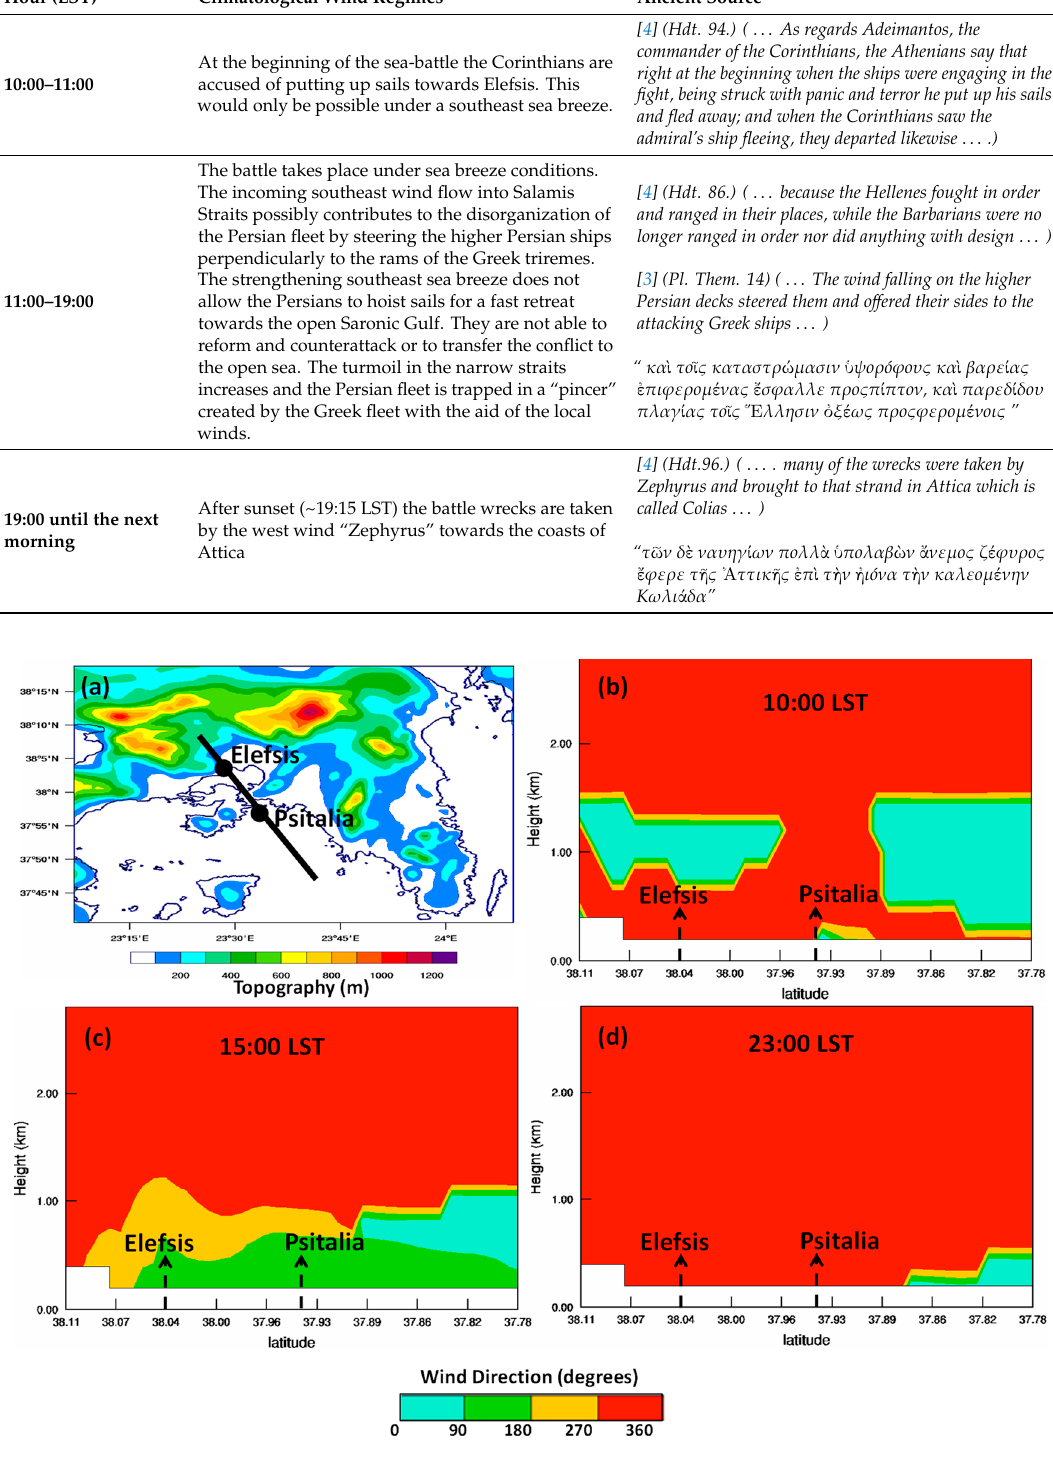
Figure 7. ( a ) Map of modeled topography (m). The black line shows the location of the cross section. Two-dimensional cross sections of wind direction (in degrees) on a vertical plane running from NW to SE in parallel to the straits of Salamis at: ( b ) 10:00 LST, ( c ) 15:00 LST, ( d ) 23:00 LST. Ten-year average (2007–2016) from WRF inner grid at 1 × 1 km grid space driven by the ERA5 monthly average fields for September. The vertical dashed lines indicate the locations of Elefsis and Psitalia.